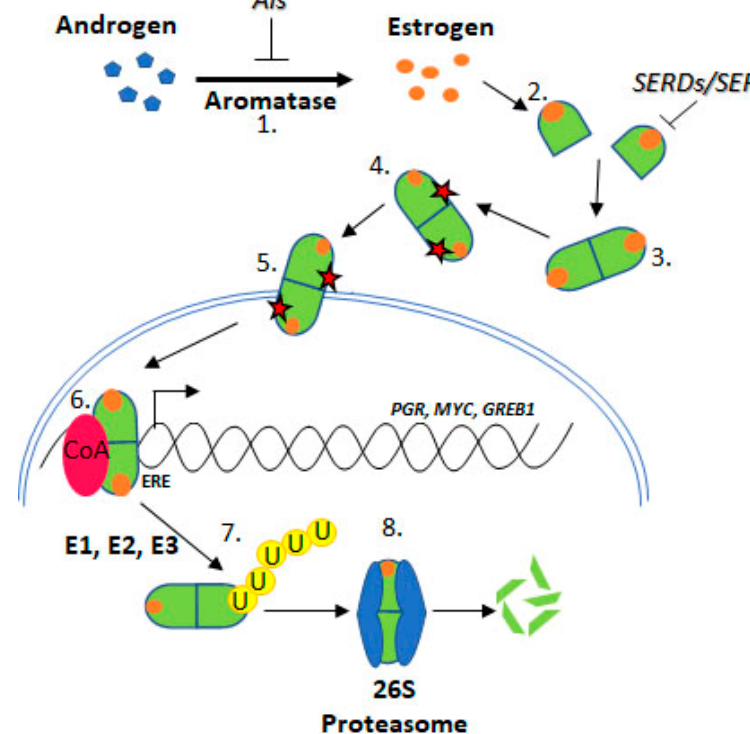
Figure 2. Estrogen Receptor Signalling and ER Targeting Treatment. Aromatase converts androgens to estrogens, Estrogen receptor binds estrogen, Dimerisation, Post translational modification, Nuclear localisation, Coactivator binding and target gene (PGR, c-Myc, GREB1) transcription, Addition of ubiquitin by E1, E2 & E3 ligases, Degradation by the 26S proteasome. Aromatase Inhibitors (AIs) inhibit the enzyme aromatase, Selective Estrogen Receptor Degraders (SERDs) and Selective Estrogen Receptor Modifiers (SERMs) prevent estrogen binding.